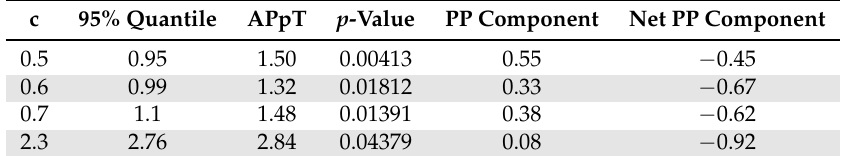
Table 12. None of the strategies selected show positive net predictive power after considering one pip per trade as an approximation for transaction